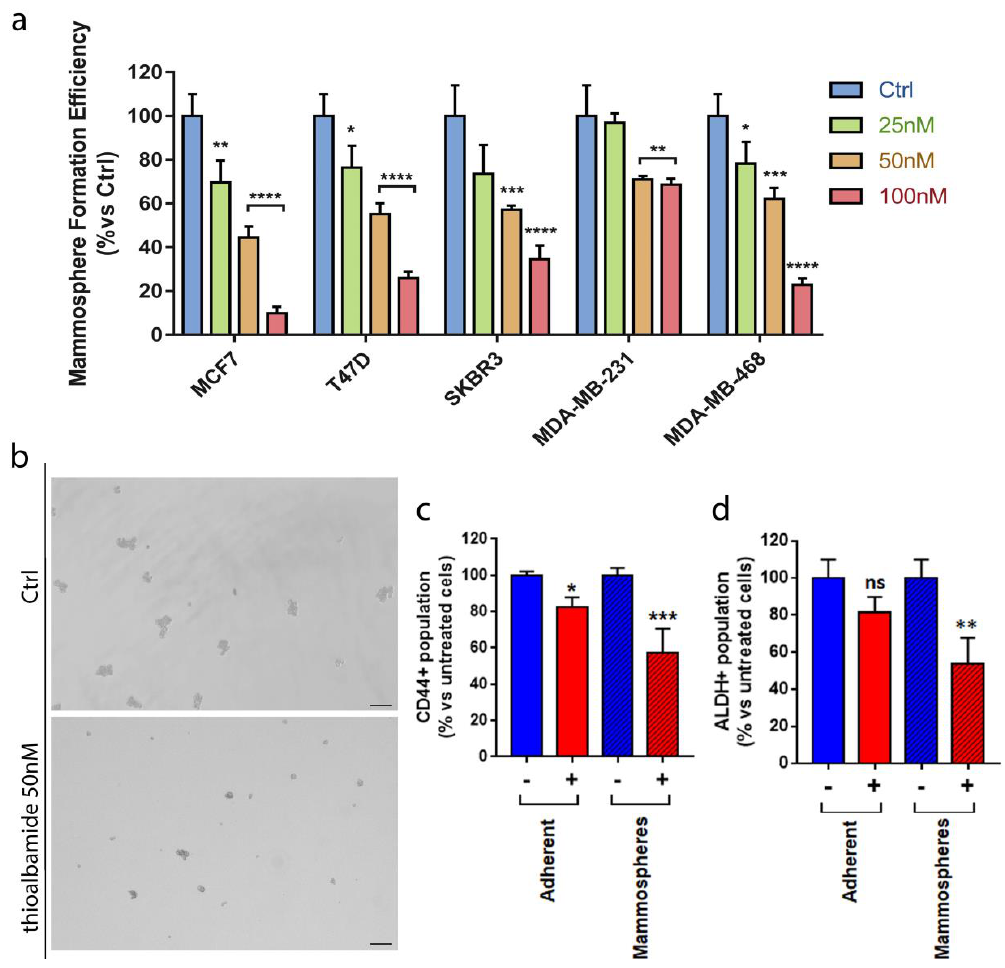
Figure 7. Thioalbamide inhibits CSCs propagation. ( a ) Mammosphere formation efficiency assay was performed on breast cancer cells (MCF7, T47D, SKBR3, MDA-MB-231, and MDA-MB-468) after treatment for five days with 25 nM, 50 nM, and 100 nM thioalbamide. All breast cancer cells tested showed a significant dose dependent reduction in mammosphere formation after treatment with thioalbamide. Mammospheres were grown in no-attachment conditions and counted using an Olympus BX41 (4× magnification) microscope. 3D-spheres >50 μm were counted using an eye piece (“graticule”), and the percentage of cells plated that formed spheres was calculated and referred to as percent mammosphere formation efficiency (MFE). ( b ) Representative images of MCF7 cell mammospheres. Scale bar: 125 µm. ( c ) CD44 expression and ( d ) ALDH activity were chosen as CSC markers. Anti-human CD44-APC antibodies and ( d ) an ALDEFLUOR assay kit were used to stain MCF7 cells. Samples were analyzed using a SONY SH800 cell sorter. A significant reduction of CD44-positive cells and ALDH-positive cells was detected after treatment with 50 nM of thioalbamide in MCF7 cells grown in no-attachment (mammospheres) conditions. Values represent the mean ± SD of three independent experiments. ns = not significant; * P value < 0.05; ** P value < 0.01; *** P value < 0.001; **** P value <